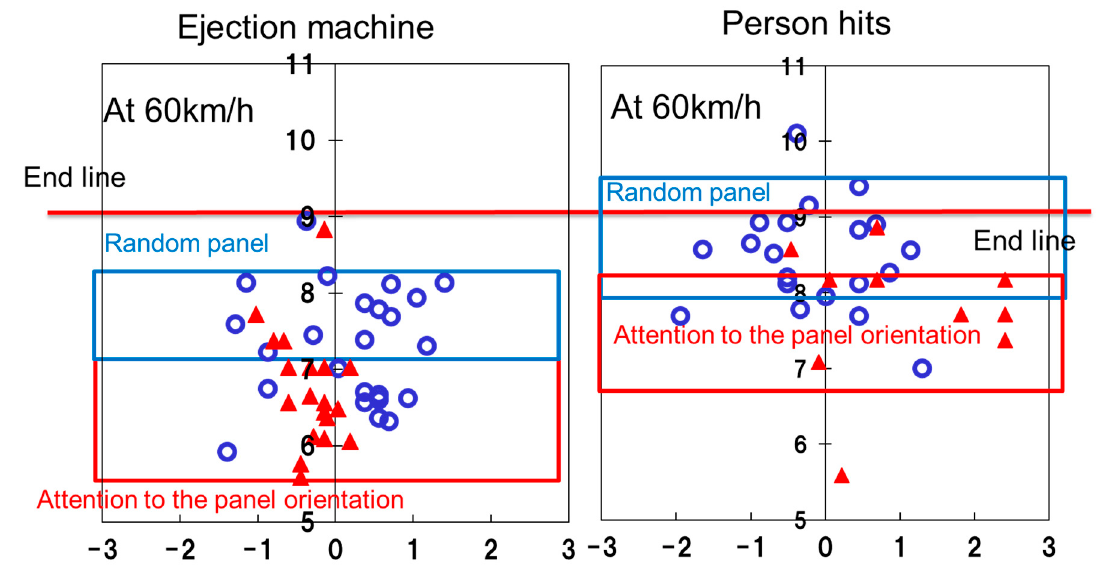
Figure 15. Difference in the drop position of the ball between the ejection machine and a human hitter. The triangles represent the case of serving with panel C facing, and the white circles represent the case of serving with a random panel orientation.